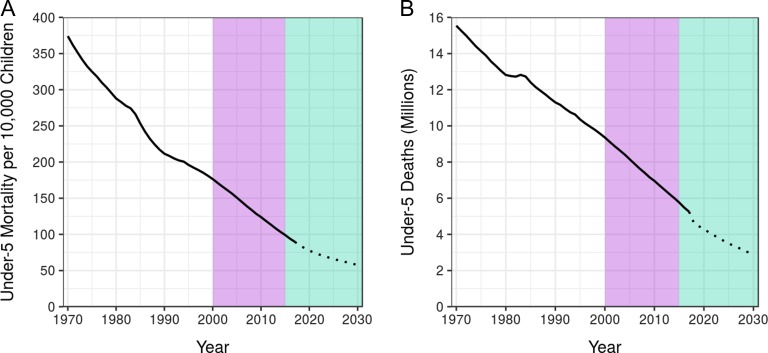
Trends in under-5 mortality in 103 LMICs, 1970–2030. (A) Under-5 mortality rate per 10 000 children. (B) Total under-5 deaths in millions. The mortality rate was determined by dividing the number of deaths by the population among all children <5 y of age. The purple area identifies the era of the MDGs and the green area represents the time remaining until 2030, the target year of the SDGs.1 The projected under-5 mortality rate and total deaths are indicated by the dotted portion of each line.6